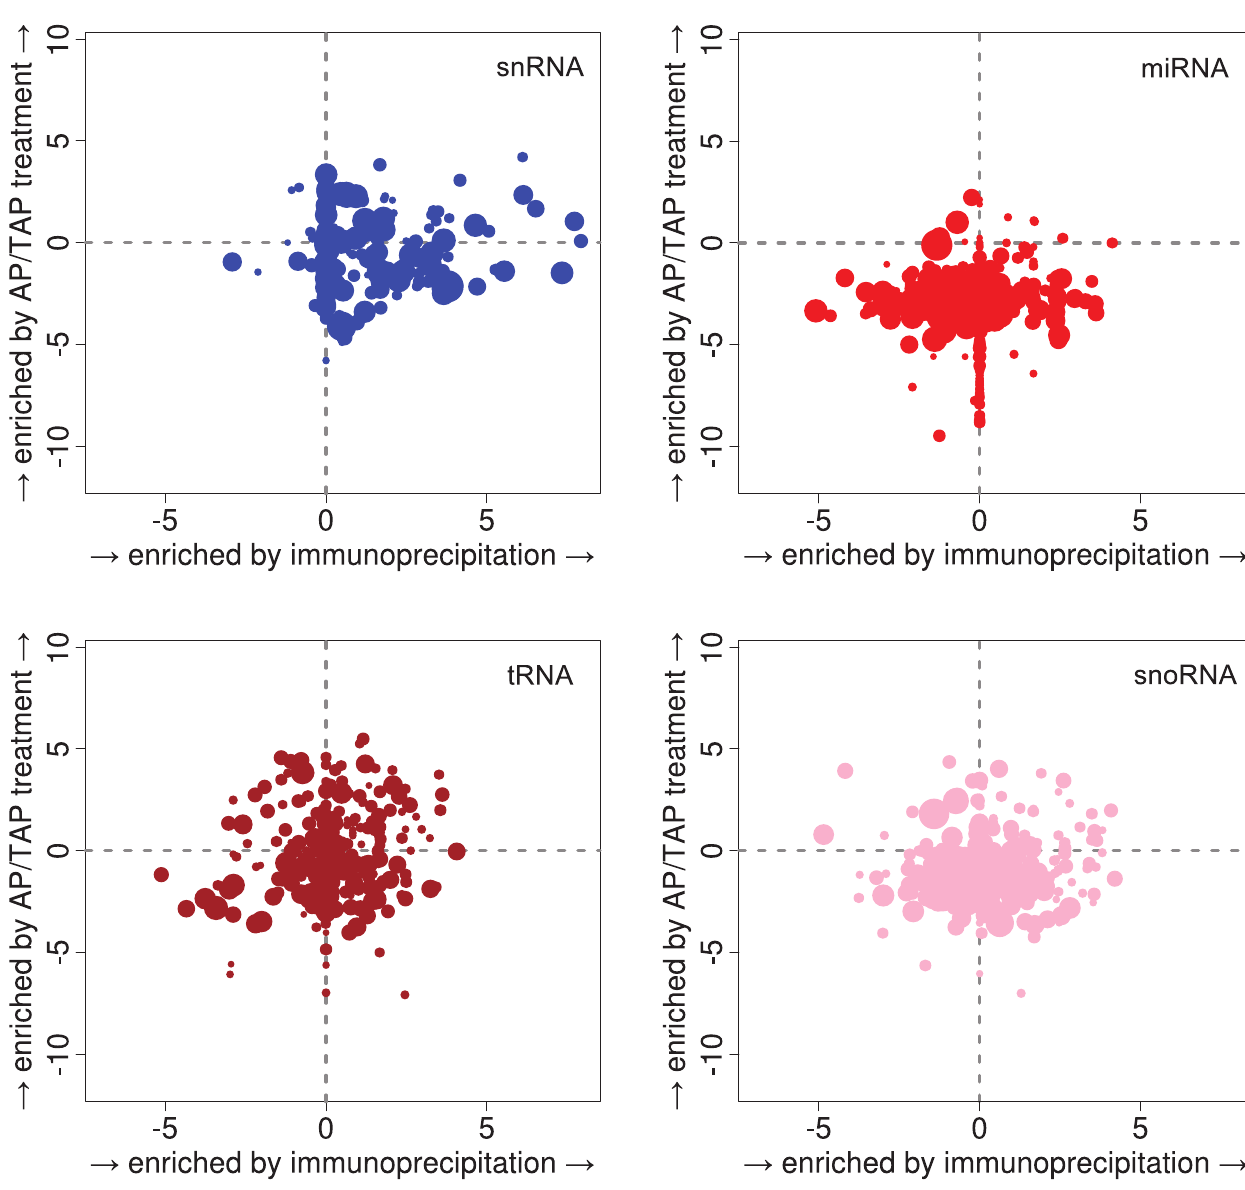
Figure 3. Differential expression analysis of annotated sRNAs. Enrichment of annotated tag clusters in the IP K121 and Capped sRNA libraries respectively to their controls. Horizontal and vertical axis: fold changes in logarithmic scale. Each dot represents one cluster, with a size proportional to its average expression.